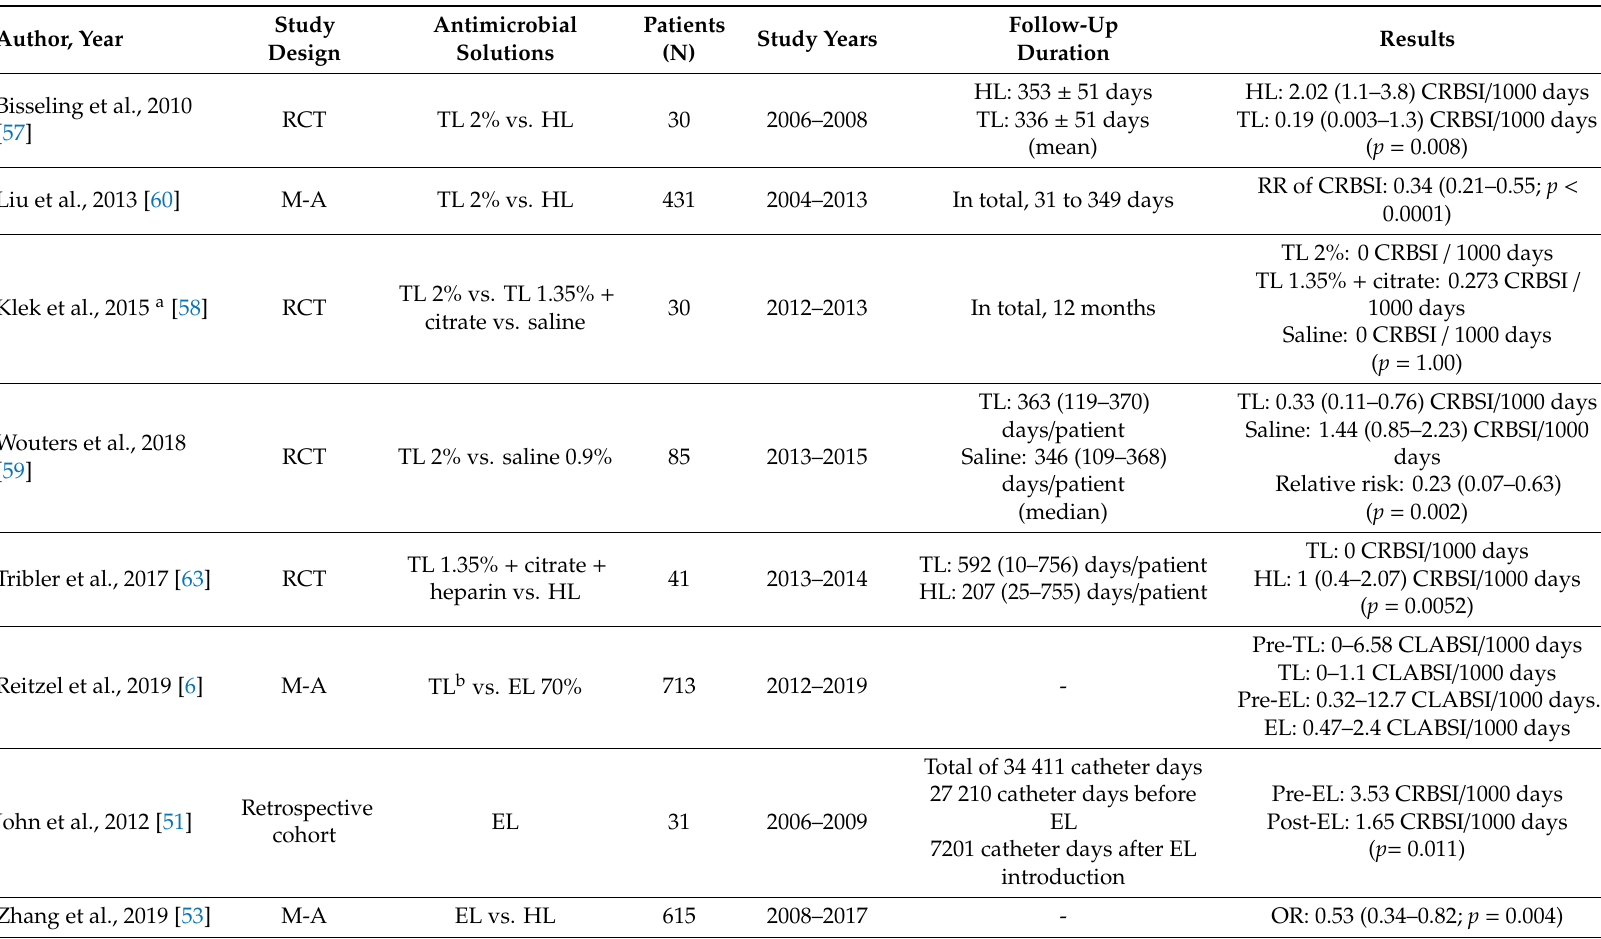
Table 2. Studies on taurolidine and ethanol lock for the prevention of CRBSI in adults receiving home parenteral